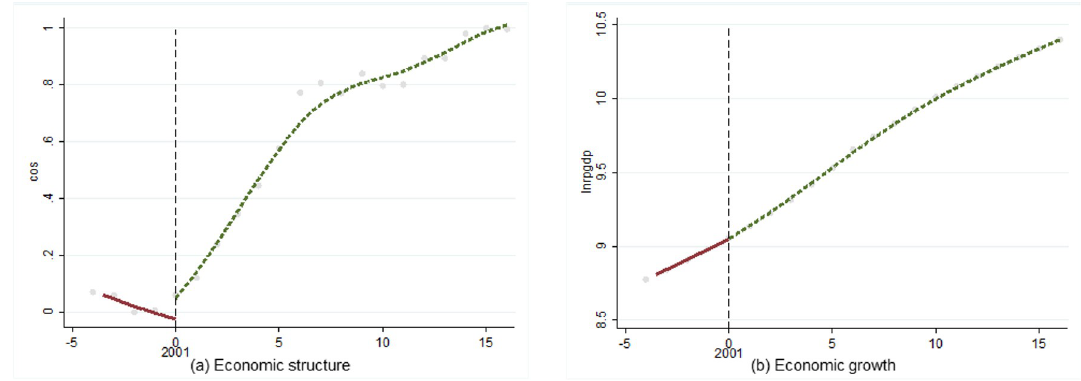
Fig 4. Discontinuity point in 2001 (lower-middle-income).